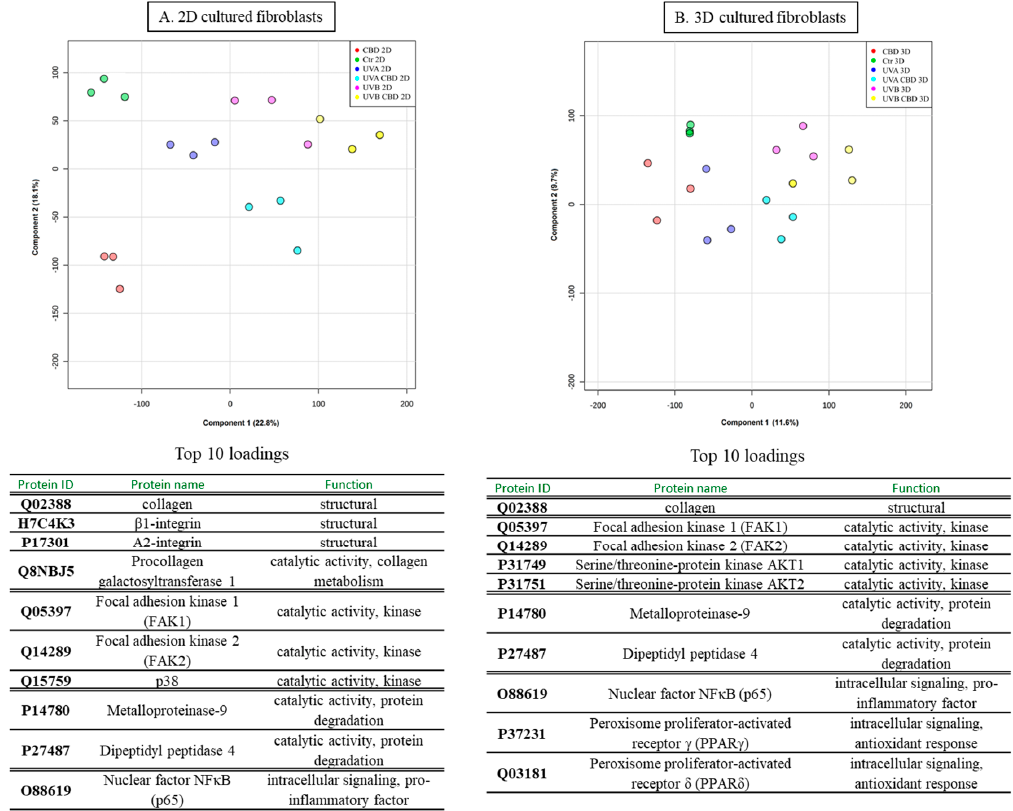
Figure 2. Principal component analysis (PCA) and top 10 loadings for component 1 (grouped according to their functions) of control skin fibroblasts and irradiated with UVA (20 J/cm 2 ), UVB (200 mJ/cm 2 ) or/and treated with cannabidiol (CBD, 4 μ M) in two-dimensional (2D) ( A ) or three-dimensional (3D) culture model ( B ).